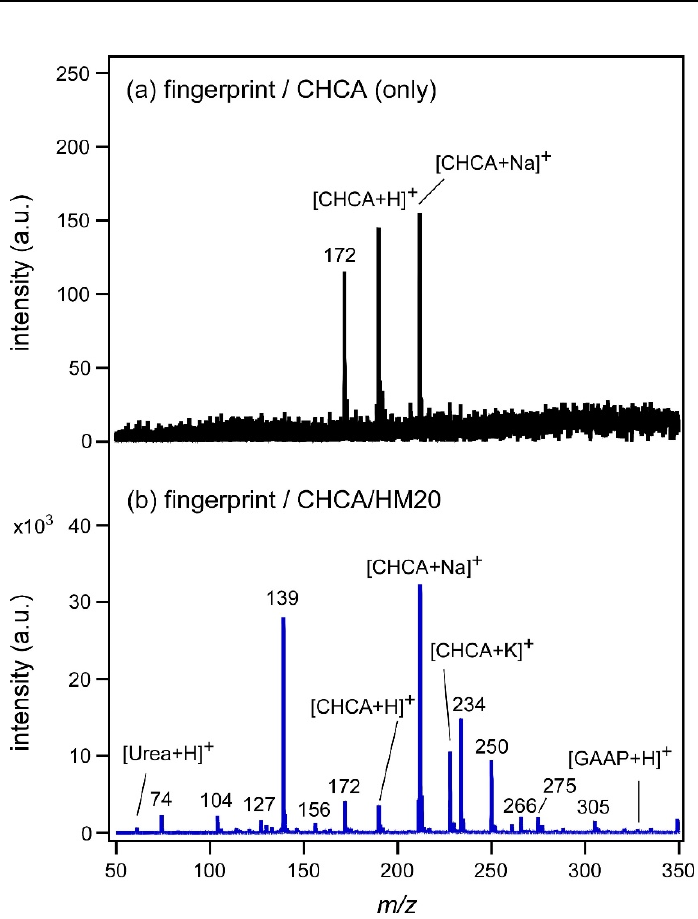
Figure 2. ( a ) MALDI and ( b ) SALDI mass spectra of fingerprint taken 4 h after ingesting AAP